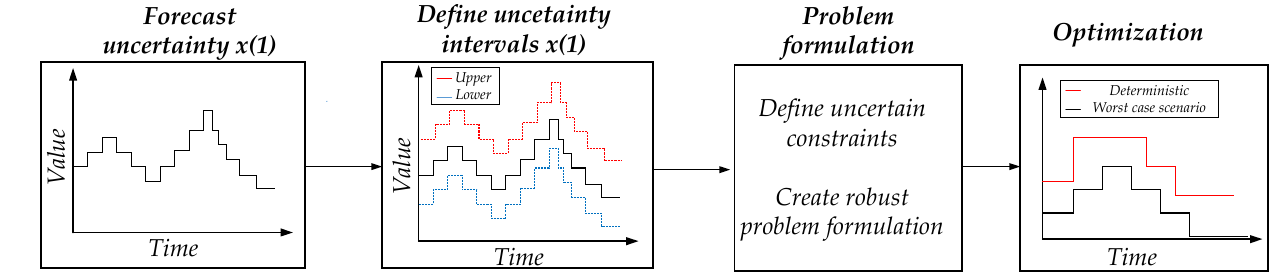
Figure 8. Robust optimization operation in